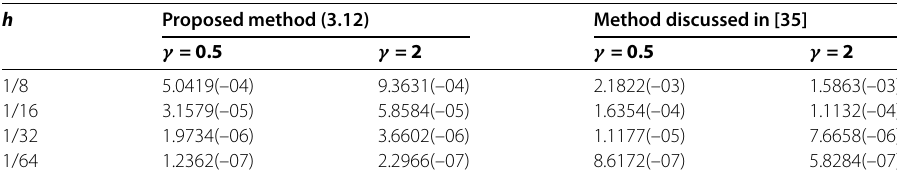
Table 4 Problem 6.3: The maximum absolute errors